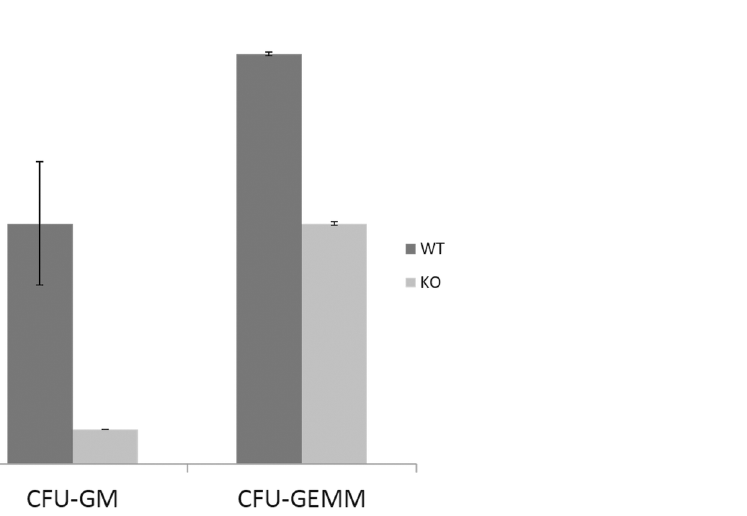
Fig 5. Colony forming assay on 6 months old miR29ab1 knockout bone marrows (n = 8; 4 ko + 4 wt; p = 0.01).